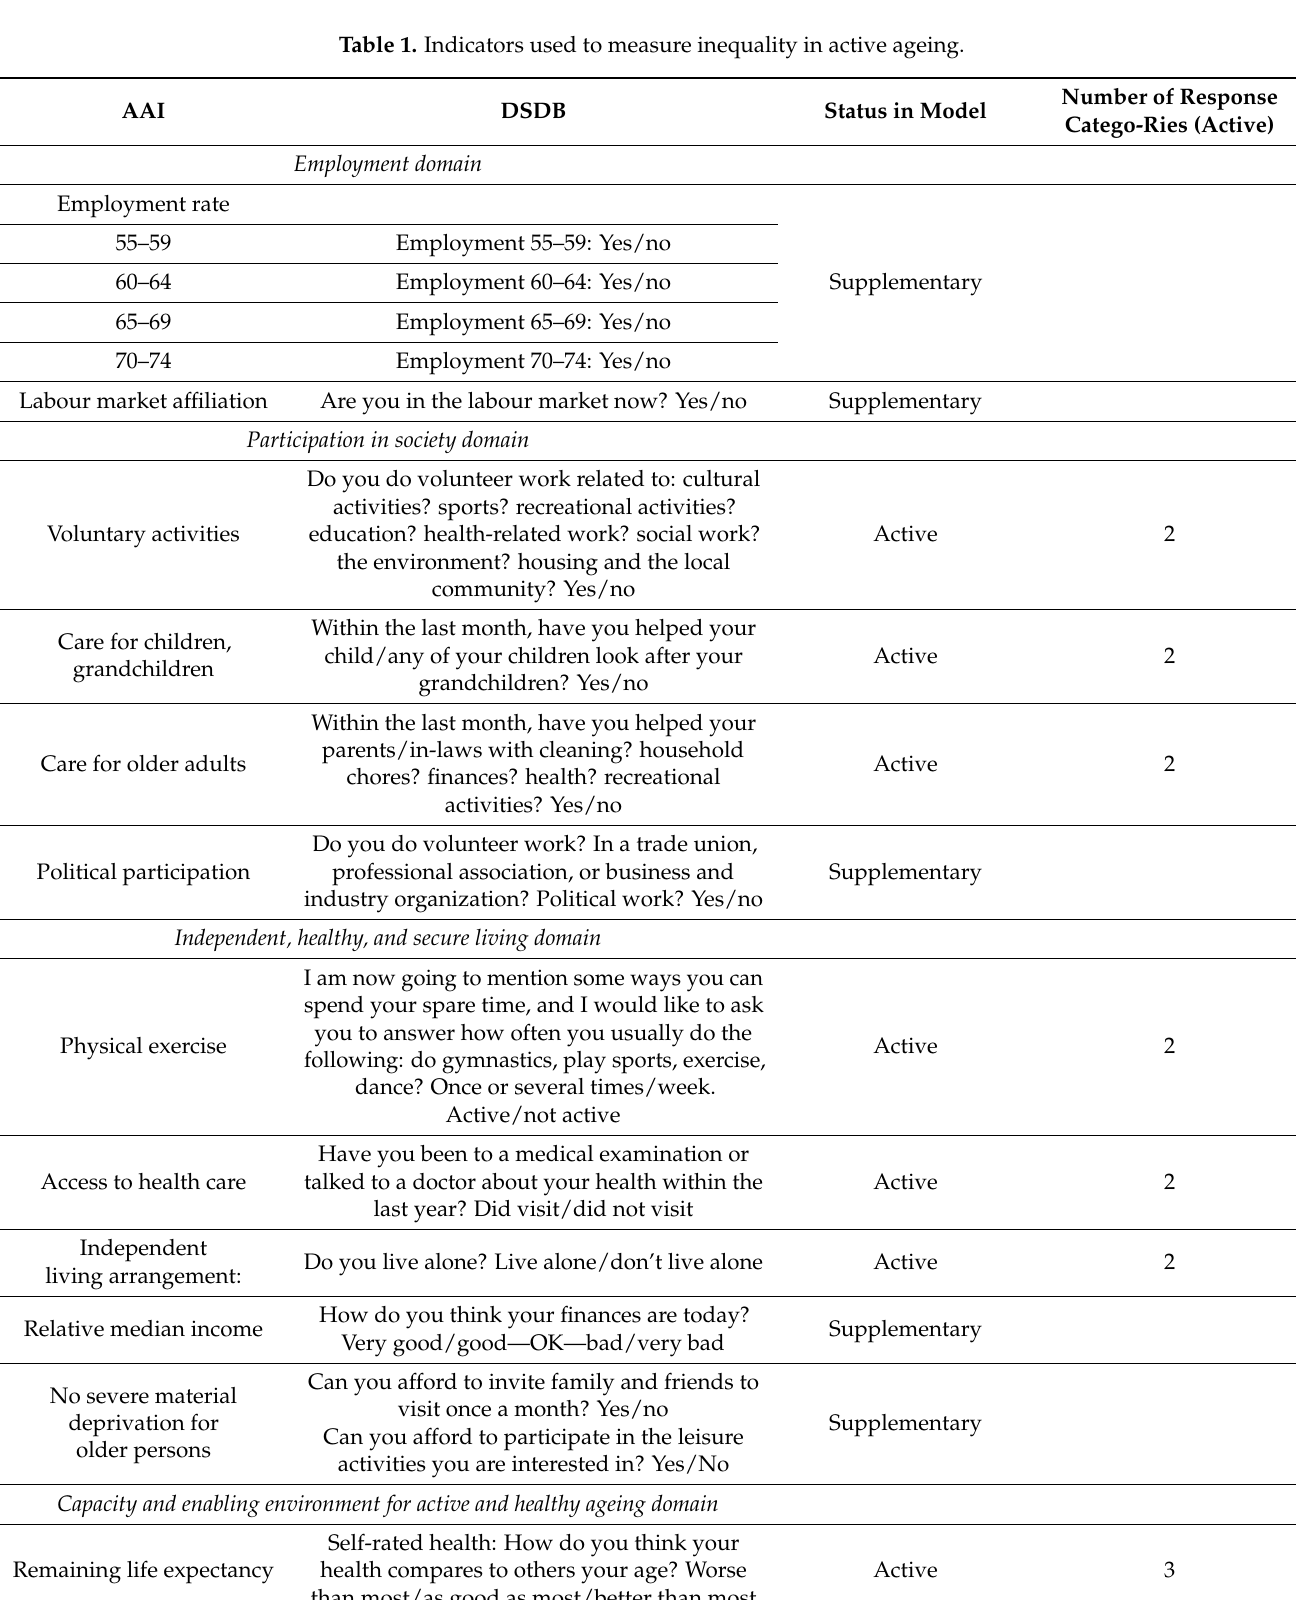
Table 1. Indicators used to measure inequality in active